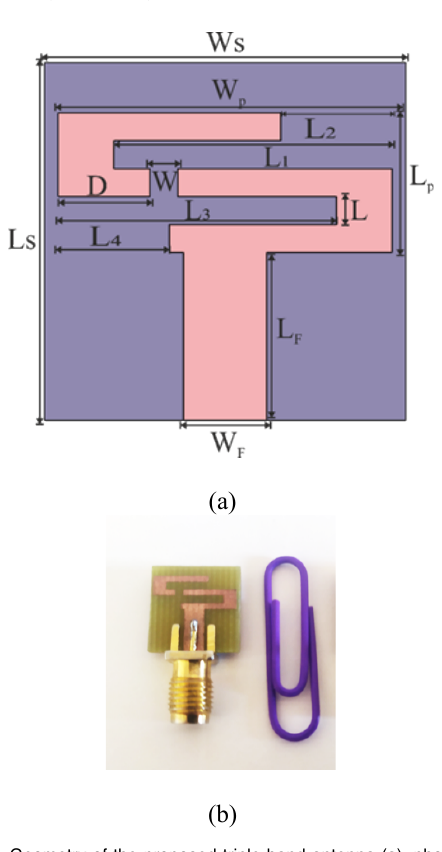
FIGURE 1. Geometry of the proposed triple band antenna (a), photograph of the fabricated antenna (b).